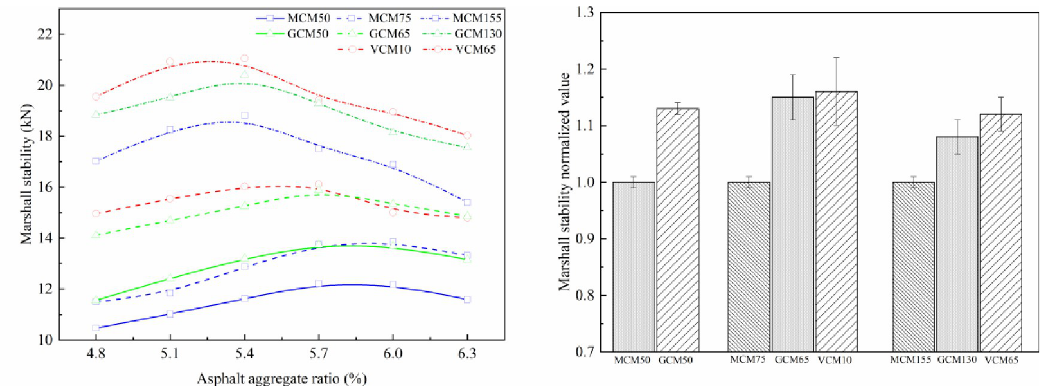
Fig 7. Effect of compaction on Marshall stability under different compaction methods. (a) Marshall stability versus asphalt aggregate ratios. (b) Marshall stability normalized value.